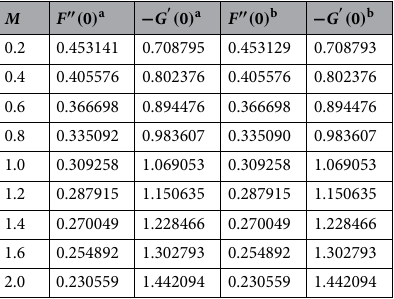
F , F ′ , G and temperature ( θ ) for different values of elasticity (cid:31) (cid:30)